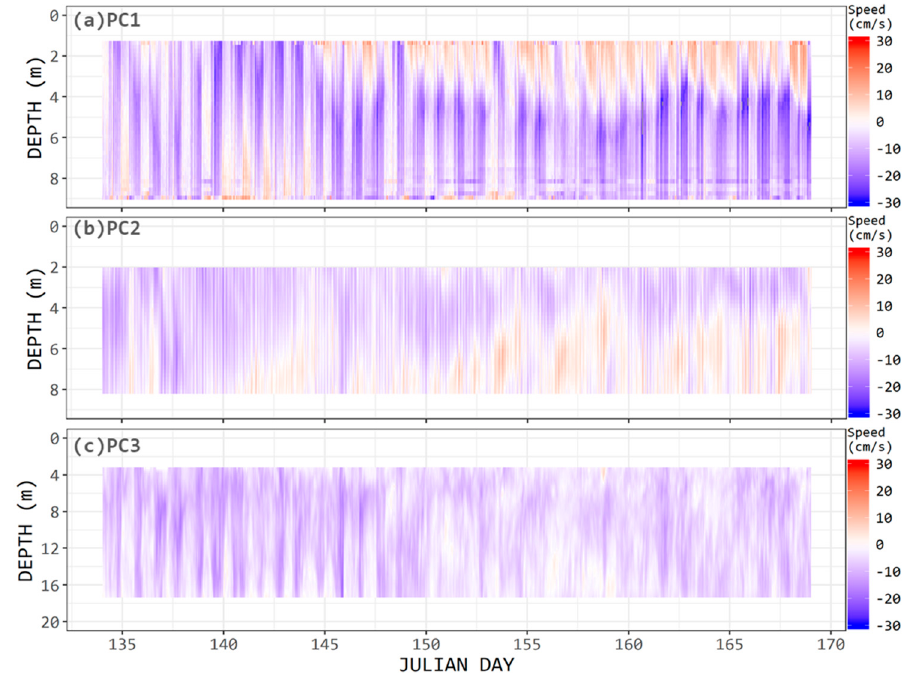
Figure 3. Observed time-depth profiles of flow velocity at ( a ) PC1, ( b ) PC2, and ( c ) PC3. The positive (+, red) and negative (–, blue) values of the color bar indicate the upstream and downstream flow, respectively. Julian day is the day of year 2016 and the depth is measured from the water surface level.